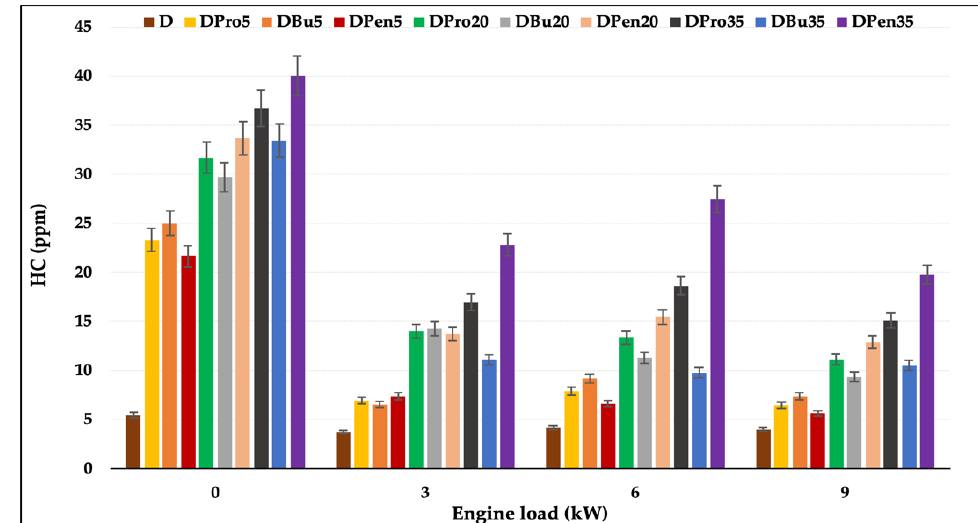
Figure 4. Comparison of HC emission with engine load for test fuels.